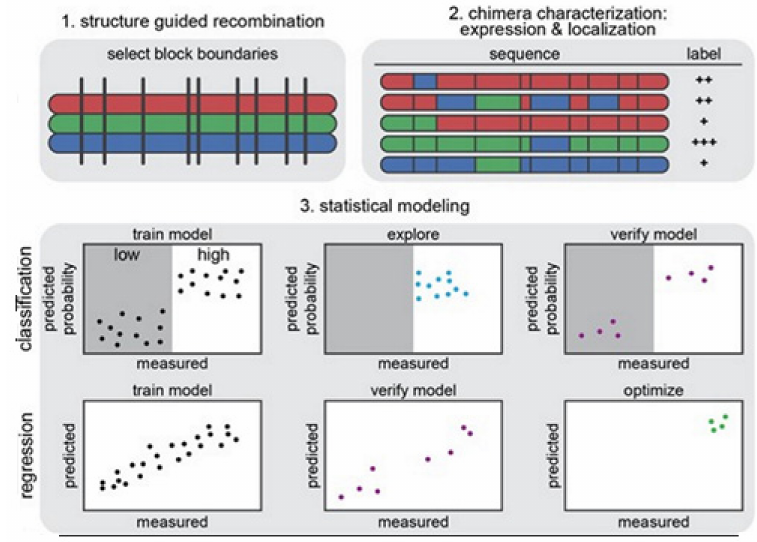
Figure 14. Generalized approaches to the ML of the protein (ChR) structure-function relationships. Here the diversity generation, the measurements on a set for training, and the modeling have been demonstrated.